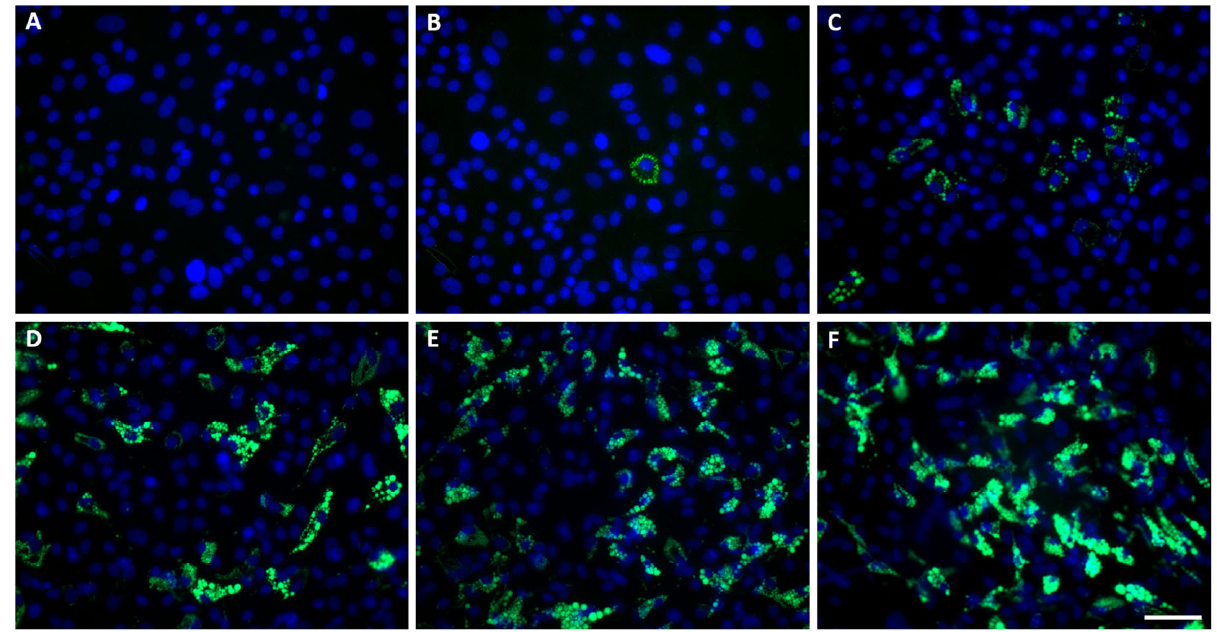
Figure 1 . The adipocyte differentiation experiment. Mesenchymal stem cells (MSCs, day 0 of differentiation) were treated with adipogenic hormonal inducers and were cultured for ten days. Cells and media were collected for total RNA isolation on days 0 ( A ), 2 ( B ), 4 ( C ), 6 ( D ), 8 ( E ), and 10 ( F ). Representative images were taken after staining the lipid droplets with BODIPY 493/503 (green); the nuclei were counterstained with DAPI (blue). Scale bar: 50 μ m.